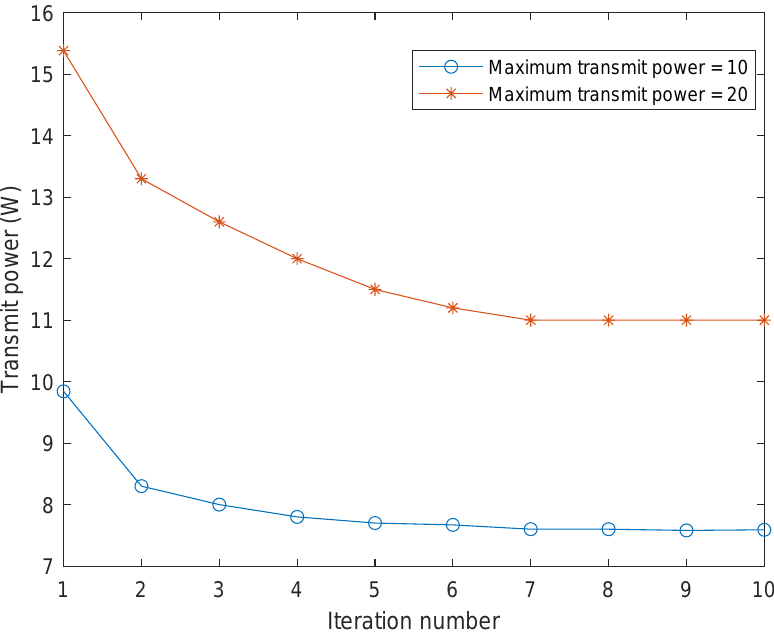
Figure 3. The convergence behaviour of the proposed algorithm.